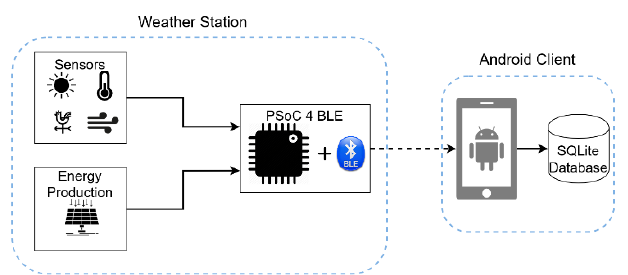
Figure 1. Developed system architecture.